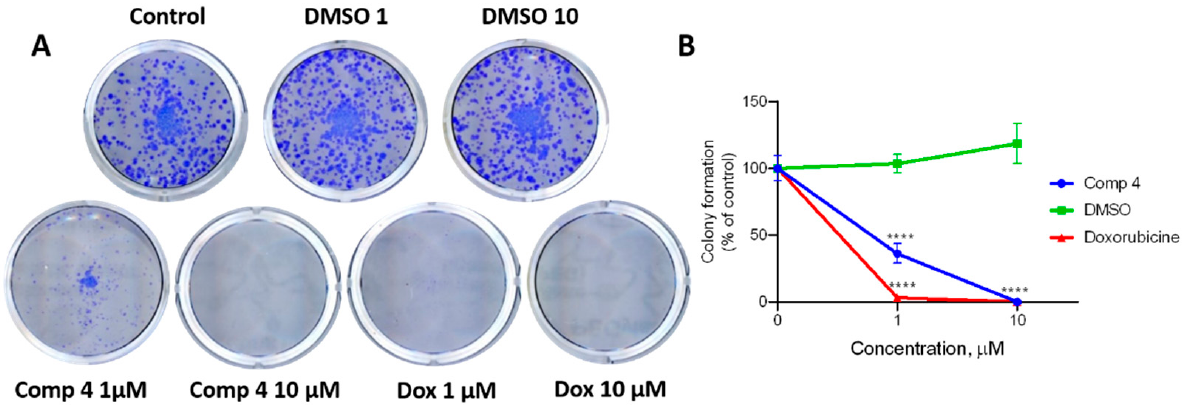
Figure 10. Clonogenic survival, performed by incubating of the MCF-7 cells with the compound 4 for 10 days. ( A ) Representative cell culture wells showing results from a clonogenic survival assay performed with cells treated with 4 , DMSO, and Doxorubicin in indicated concentrations. ( B ) This graph represents a loss of clonogenic survival of MCF-7 cells under the above-mentioned conditions (**** p < 0.0001 compared with control).